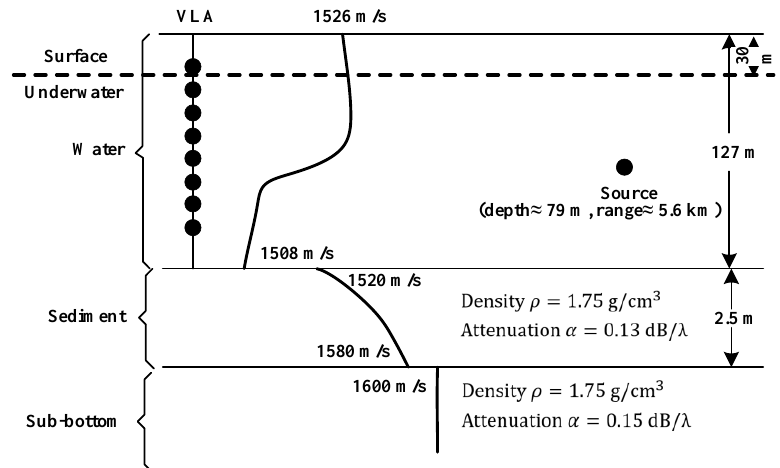
Figure 4. The experimental environment of SACLANT 1993.